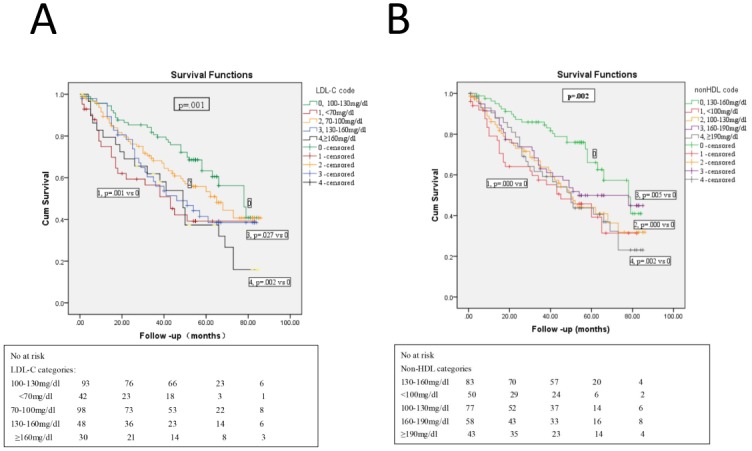
Survival curve stratified by lipid categories in maintenance dialysis patients.Note: (A) Kaplan- Meier curves for survival by the LDL-C categories. The person was categorized according to the level of LDL-C as 0 (100–130 mg/dl), 1 (<70 mg/dl), 2 (70–100 mg/dl), 3 (130–160 mg/dl) and 4 (≥160 mg/dl). The all-cause mortality risk was the lowest in patients with LDL-C category 100-130mg/dl. (B) Kaplan- Meier curves for survival by the non-HDL categories. The person was categorized according to the level of non-HDL as 0 (130–160 mg/dl), 1 (<100 mg/dl), 2 (100–130 mg/dl), 3 (160–190 mg/dl), and 4 (≥190 mg/dl). The all-cause mortality risk was the lowest in patients with non-HDL category 130-160mg/dl.